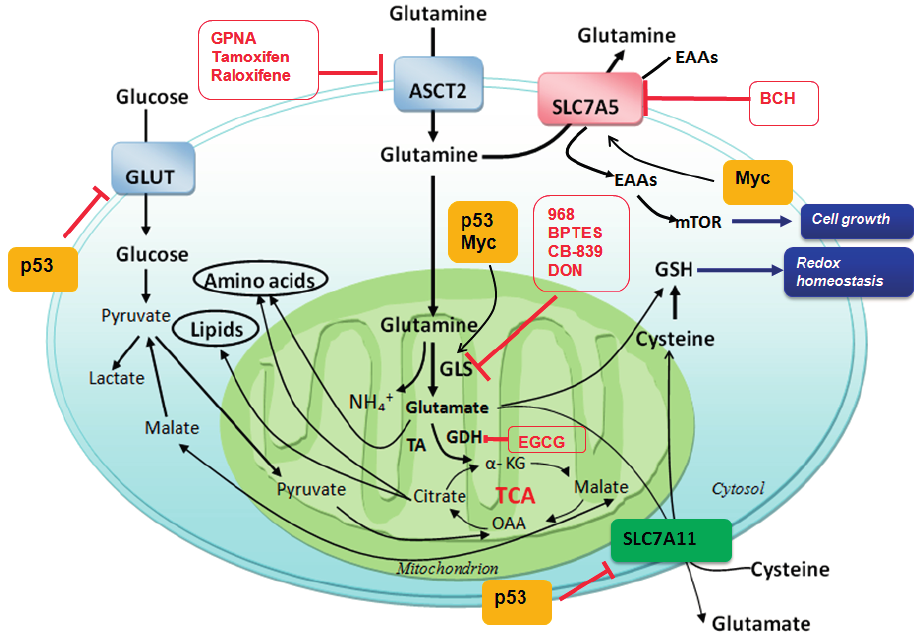
Figure 1. Glutamine metabolism and potent targets for cancer therapy. After transporting into cytosol by LAT1 ( L -type amino acid transporters 1), ASCT2 (system ASC amino acid transporters 2) and other transporters, glutamine is catalyzed by glutaminase and converts to glutamate and ammonia. It then provides macromolecular material for ammonia acid and lipid syntheses. Glutamine is also used to exchange EAAs, which could activate mTOR and promote cell growth. Glutamate is also used to exchange extracellular cysteine for GSH production. GLS is a key enzyme for glutamine metabolism, which can be inhibited by several inhibitors including 968, BPTES and CB-839, accompanying with other inhibitors of glutamine metabolism are shown in red circle. GLS, glutaminase; GDH, glutamate dehydrogenase; TA, transaminase; OAA, oxaloacetate; BCH,